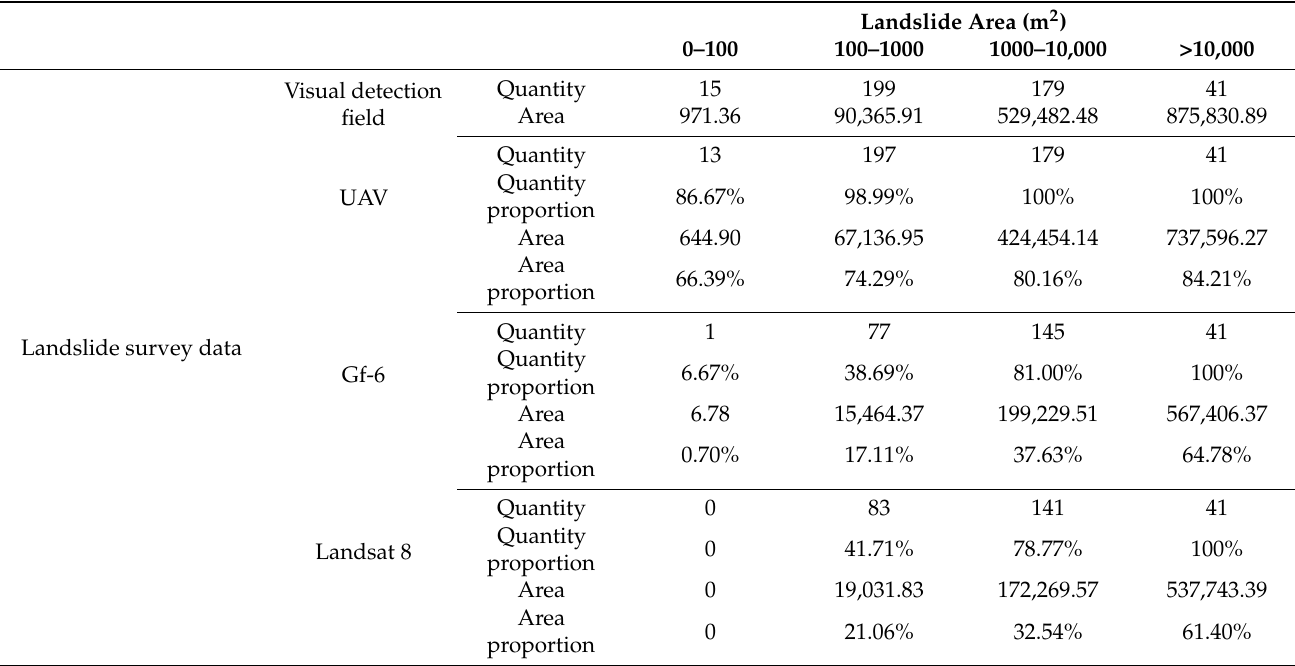
Table 4. Landslide indicators in each area of remote sensing